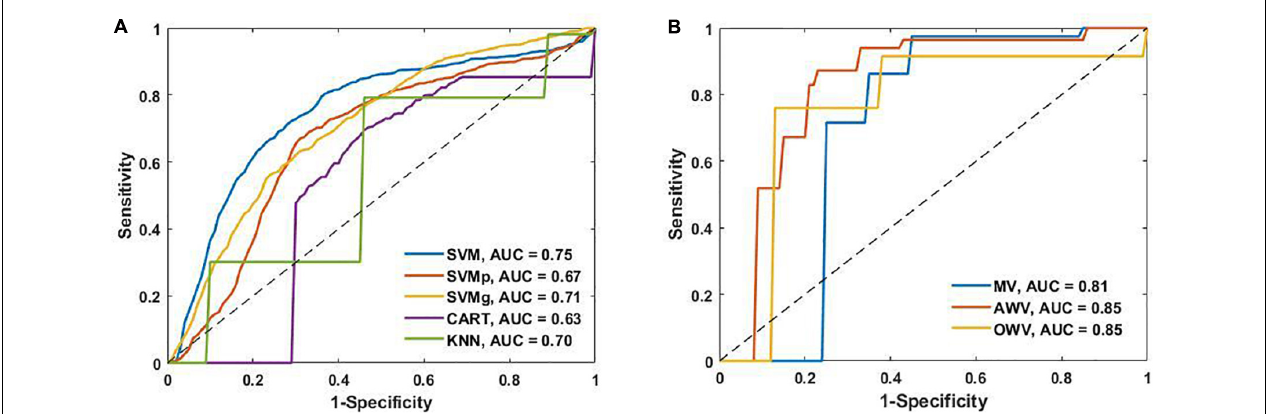
FIGURE 6 | (A) Receiver operating characteristic (ROC) curves of the single classifiers and area under the curve (AUC). (B) ROC curves of the ensemble classifiers and the AUC. AWV, accuracy weighted voting; CART, classification and regression trees; KNN, K-nearest neighbors; OWV, optimum weighted voting; SVM, support vector machine; SVMg, support vector machine Gaussian kernel; SVMp, support vector machine polynomial kernel.